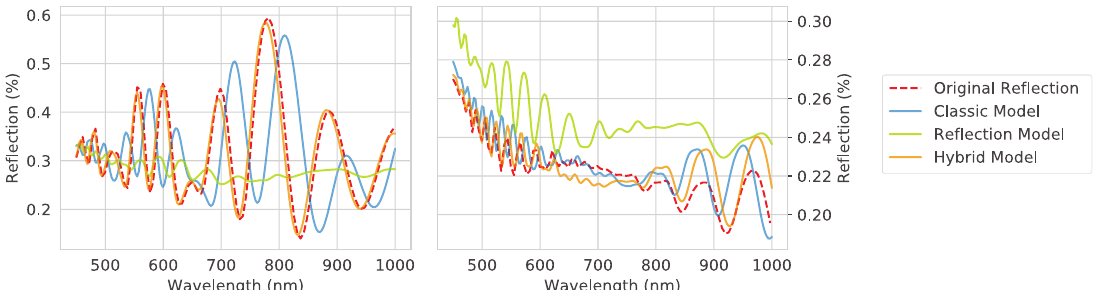
Fig. 8. Comparison of the input re fl ection curves with the ones recreated with the model predictions. The left example is one from the orange area (with dominant consistency loss) from Figure 6 and the right one is an example from the green area (with dominating regression loss).